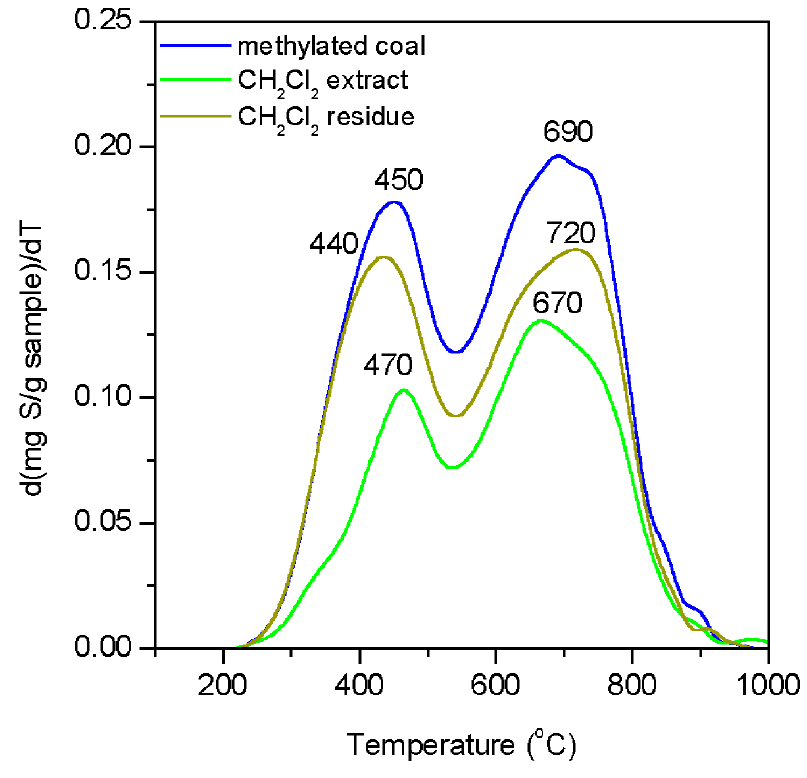
Fig. 5 AP-TPR kinetograms of Mequinenza coal methylated by Liotta method and products of its